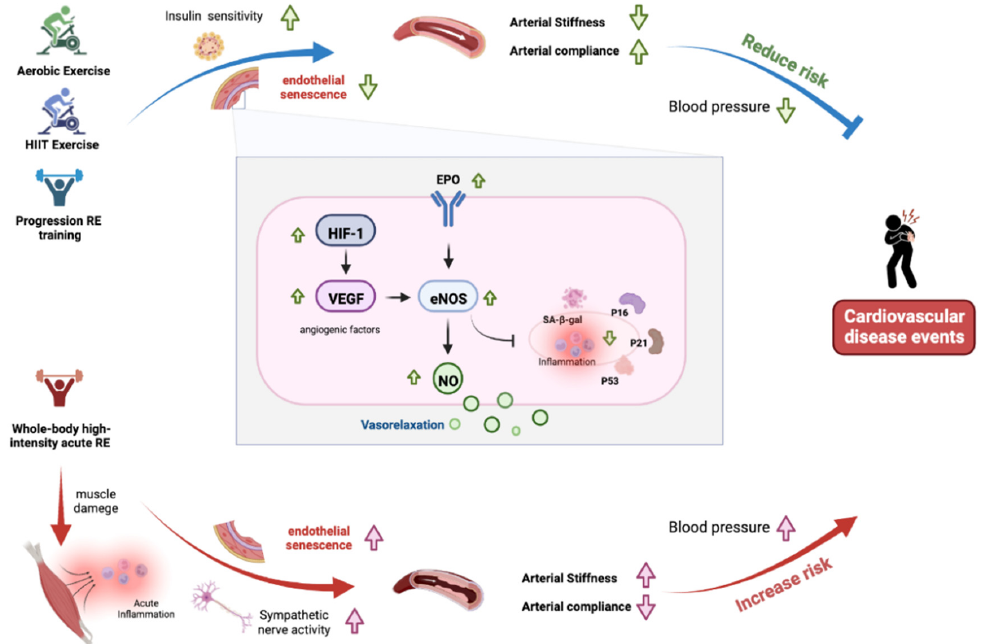
Figure 1. Arterial stiffness is an independent predictor of cardiovascular events. Different modes of exercise may have different effects on arterial stiffness. Aerobic, HIIT, and Progression RE-induced physiological and cellular levels of endothelial to promote angiogenic factors responses (VEGF, HIF-1, and EPO) and improve nitric oxide (NO) bioavailability by altering endothelial senescence markers (p53, p21, p16, and SA- β -gal), which attenuate the deleterious changes in blood pressure and vascular functions, including the increase in arterial compliance and the decrease in arterial stiffness. However, whole-body high-intensity acute RE-induced muscle damage, which leads to the transient increase in inflammation, endothelial senescence, and sympathetic activation may contribute to the temporary elevation in blood pressure and arterial stiffness. RE: resistance exercise; VEGF: vascular endothelial growth factor; HIF-1 α : hypoxia-inducible factor 1-alpha EPO: erythropoietin; eNOS: endothelial nitric oxide synthase; SA- β -gal: senescence-associated- β -galactosidase.